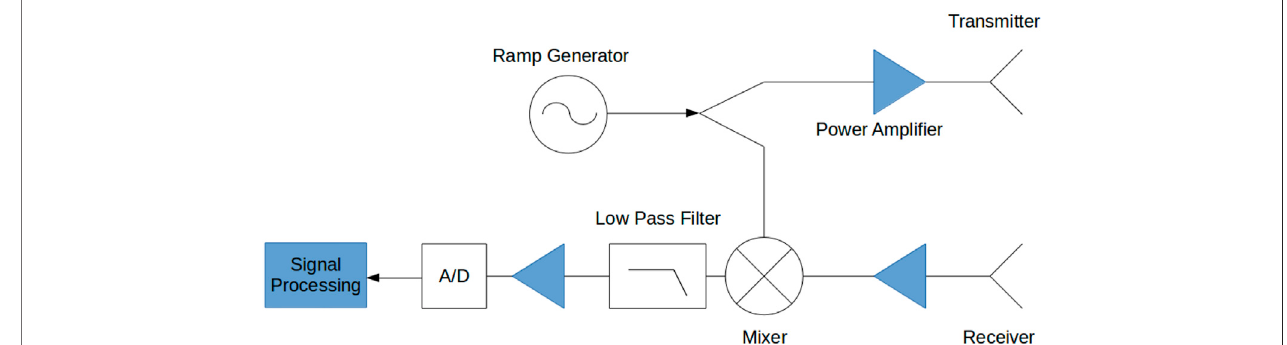
FIGURE 1 | Basic block diagram of FMCW radar.